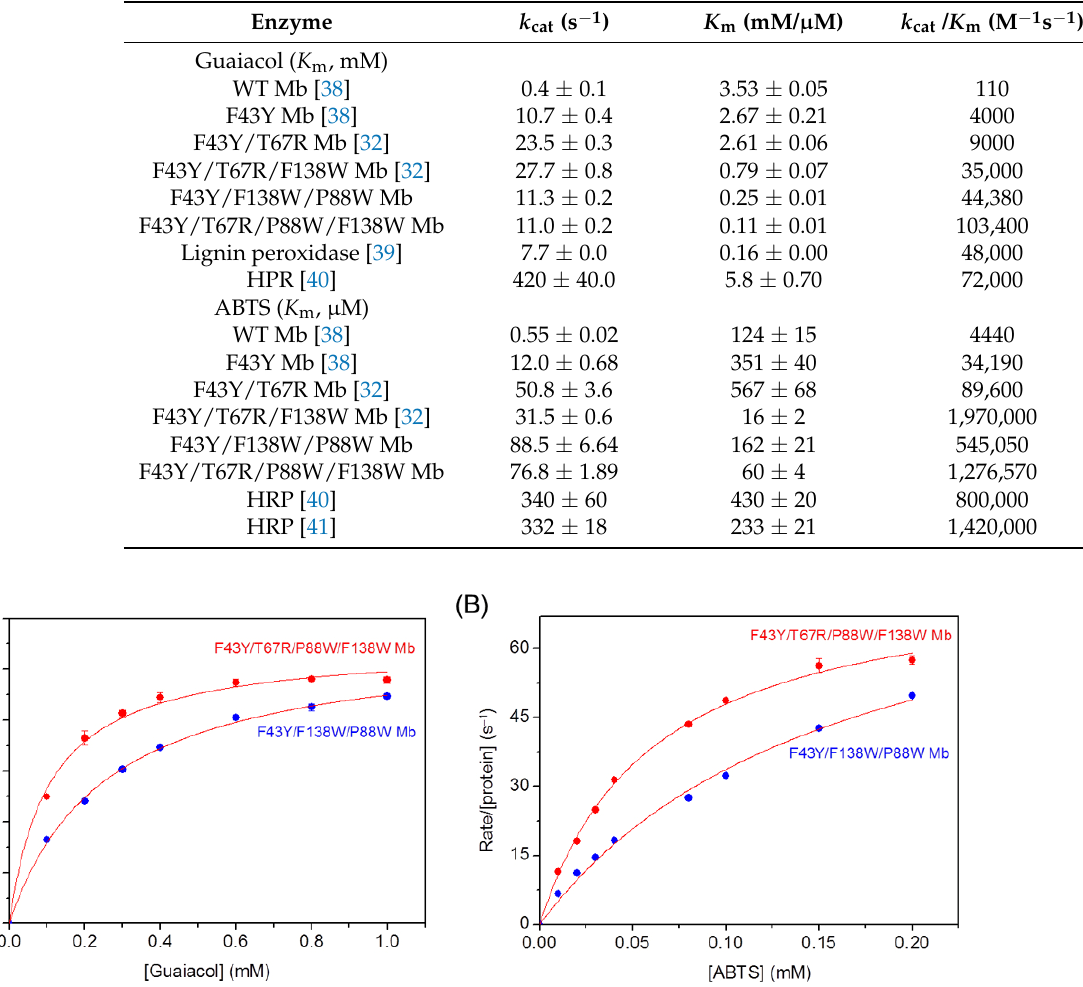
Figure 2. Steady-state rates of H 2 O 2 -dependent oxidation of guaiacol ( A ) and ABTS ( B ) catalyzed by F43Y/F138W/P88W Mb and F43Y/T67R/P88W/F138W Mb, with increasing the substrate concentra- tions. Reaction conditions: 2 μ M protein, 20 mM H 2 O 2 , 50 mM potassium phosphate buffer at pH 7.0, 25 °C. The data were fitted to the Michaelis–Menten equation.